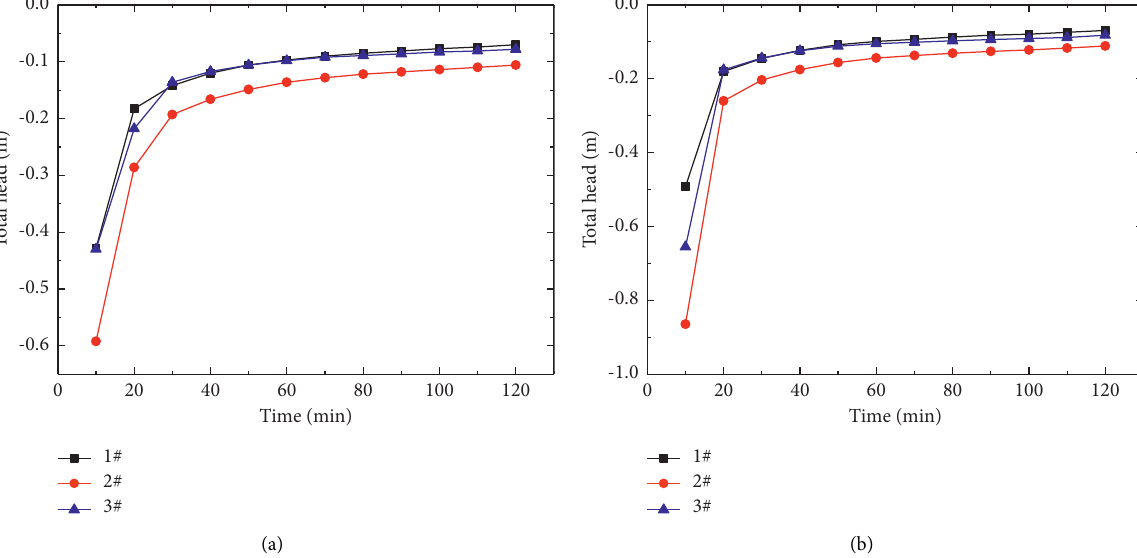
Figure 24: Total head at observation points 1–3 of (a) building 1 and (b) buildings 2–4 with seepage wells placed around building 1 in the numerical